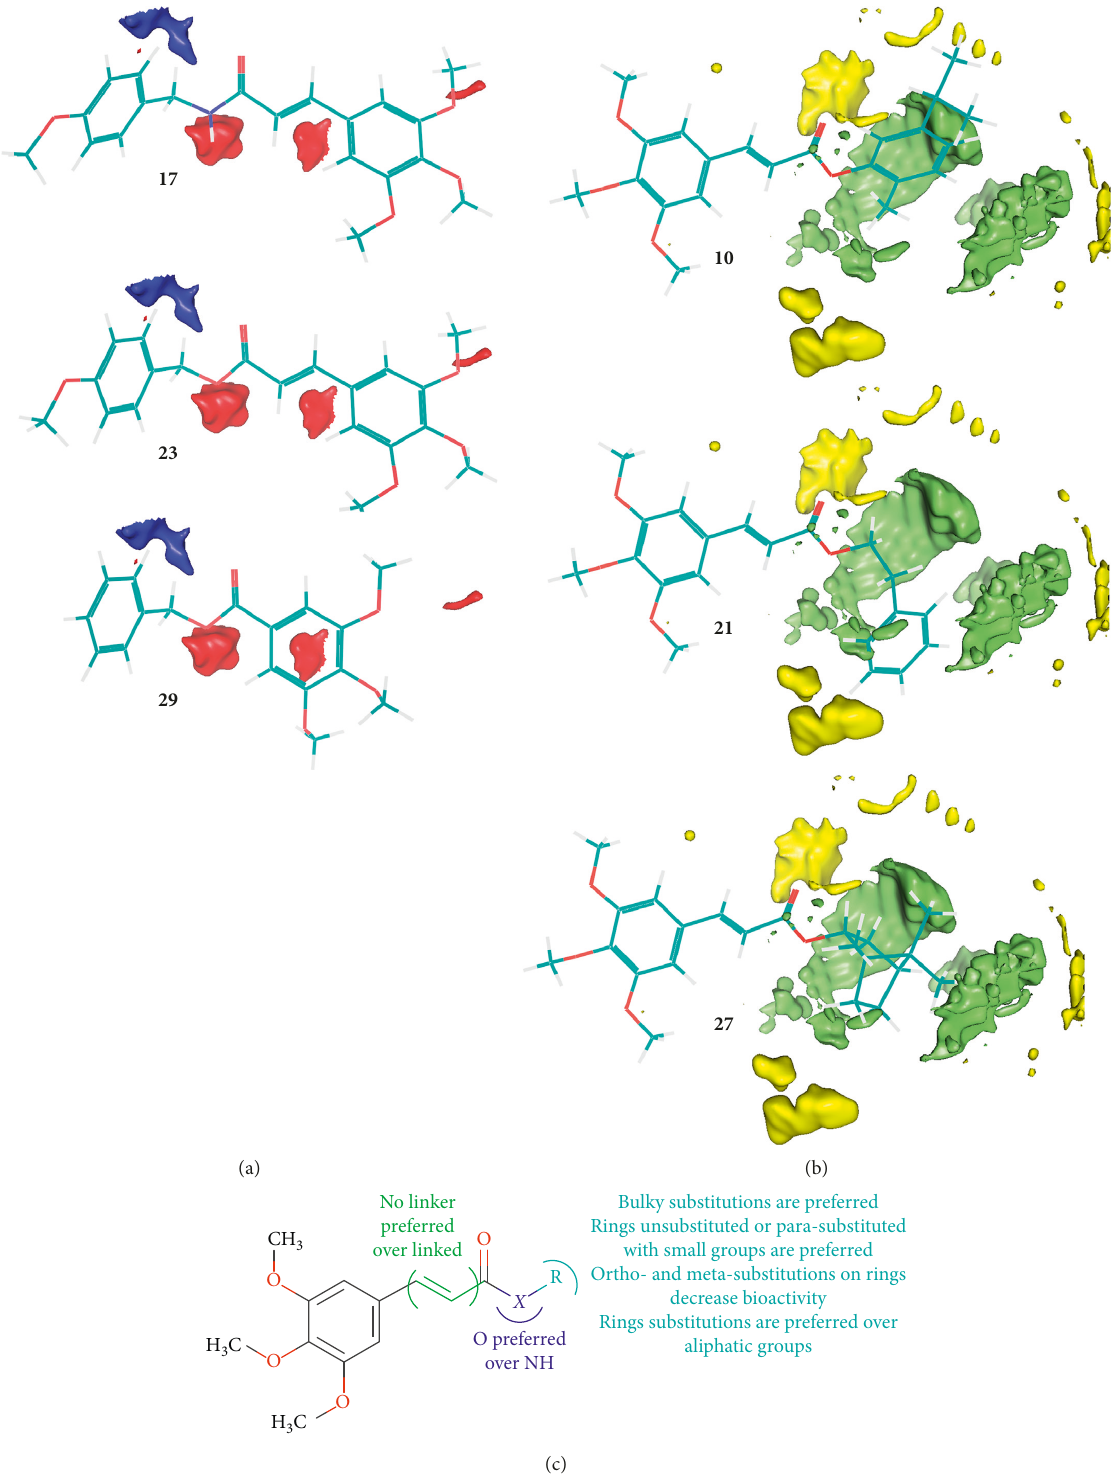
Figure 3: Summary of the 3D-QSAR model. (a) Influence of the electrostatic properties of the compounds on bioactivity. (b) Influence of the steric factor on bioactivity. (c) Summary of the SAR derived from the 3D-QSAR addition, piplartine ( 1 ) was tested against promastigote forms of L. infantum and L. amazonensis and reached IC